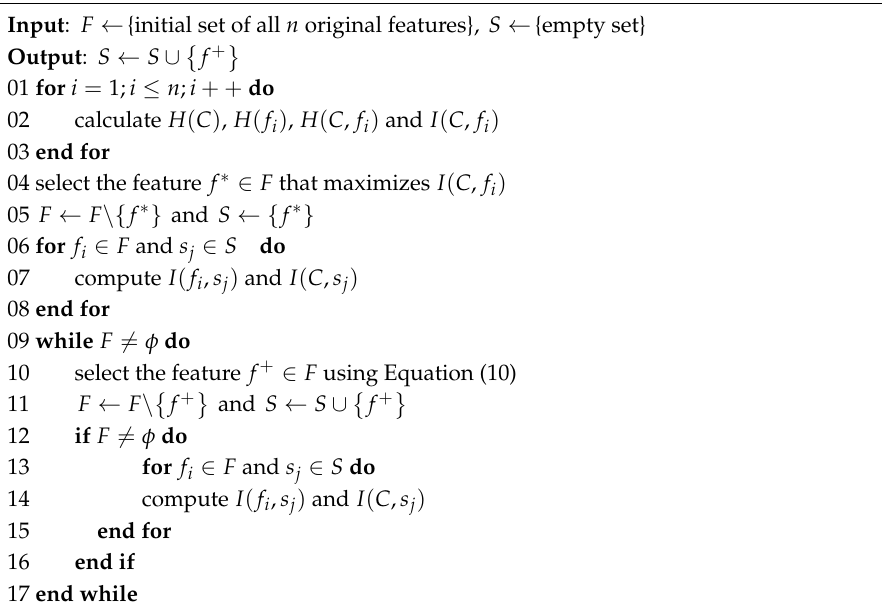
Algorithm 1. The Proposed New